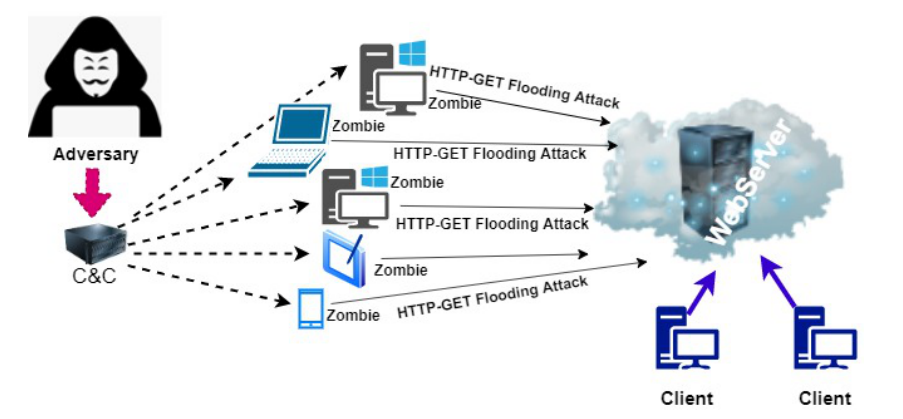
Figure 8. HTTP-GET flood attack. Table 6. Summary of attacks: their location, tools, and impacts.